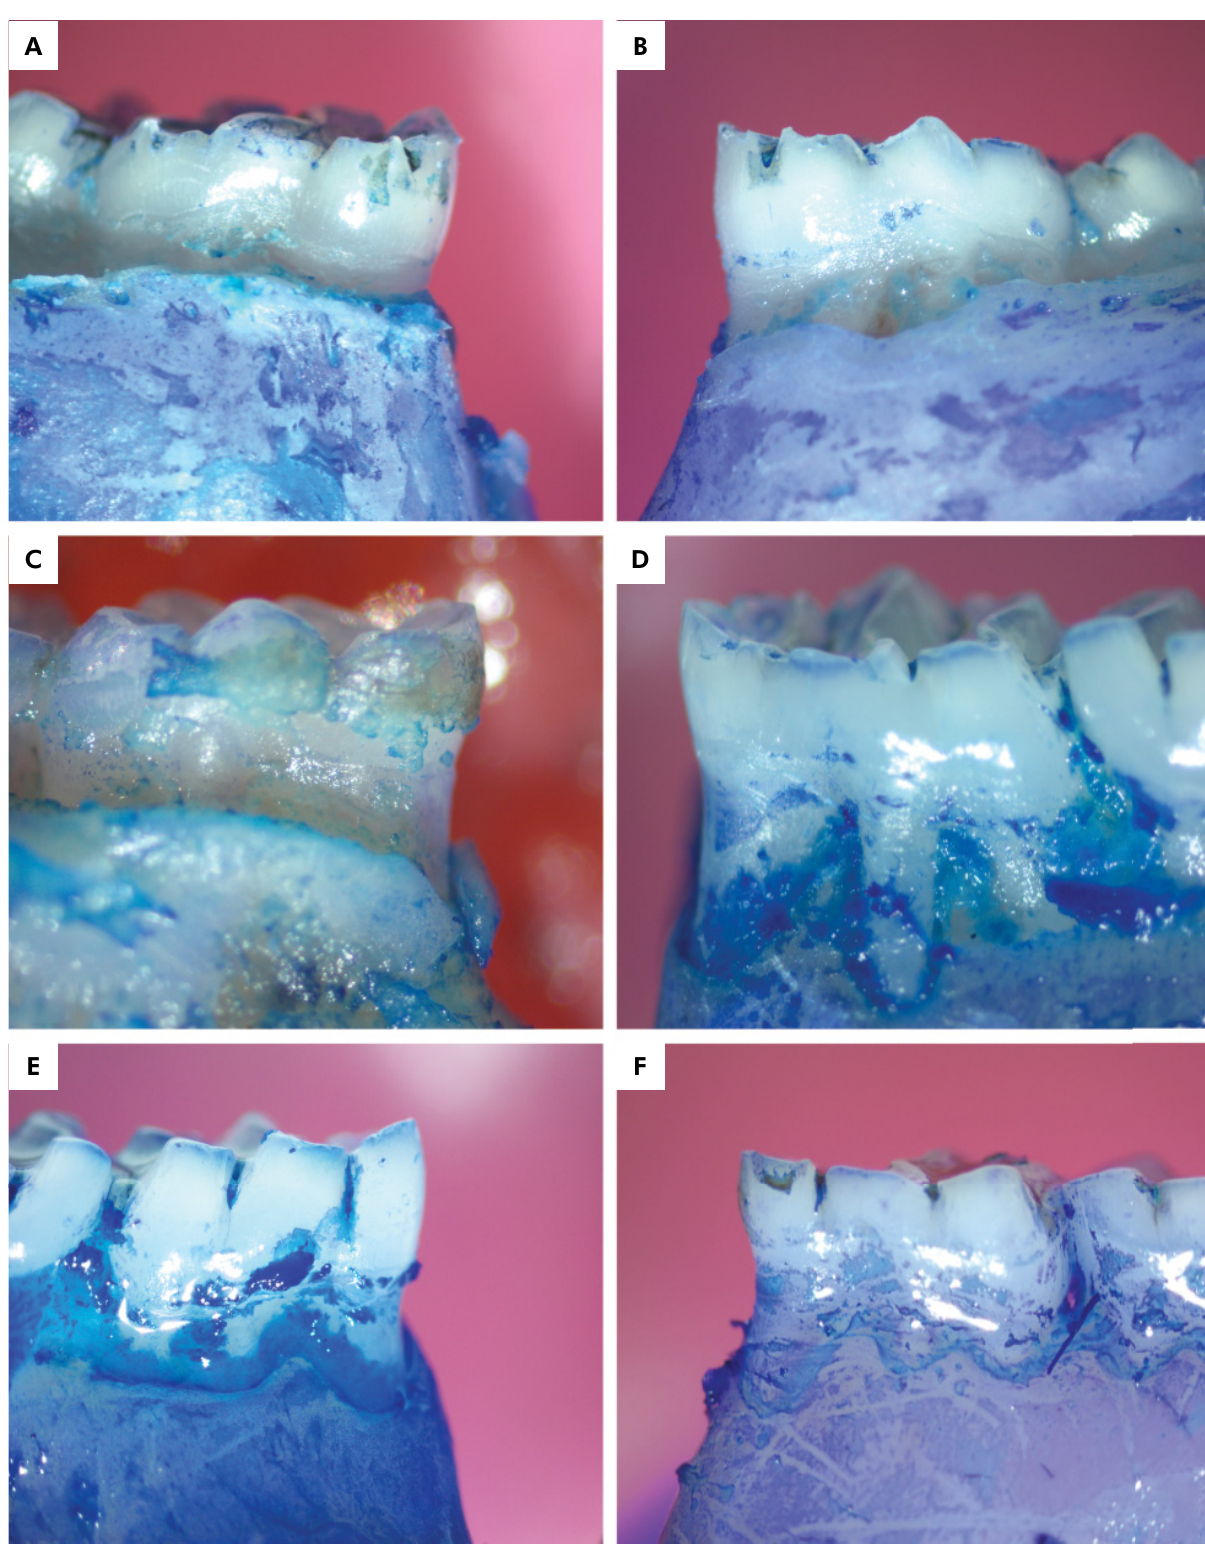
Figure 1. Representative photographs of the alveolar bone loss in the mandibular first molar tooth in the Control (A), 0.4 mgC (B), 1 mgC (C), LO (D), 0.4 mgC-L (E), and 1 mgC-L (F) groups at 30th